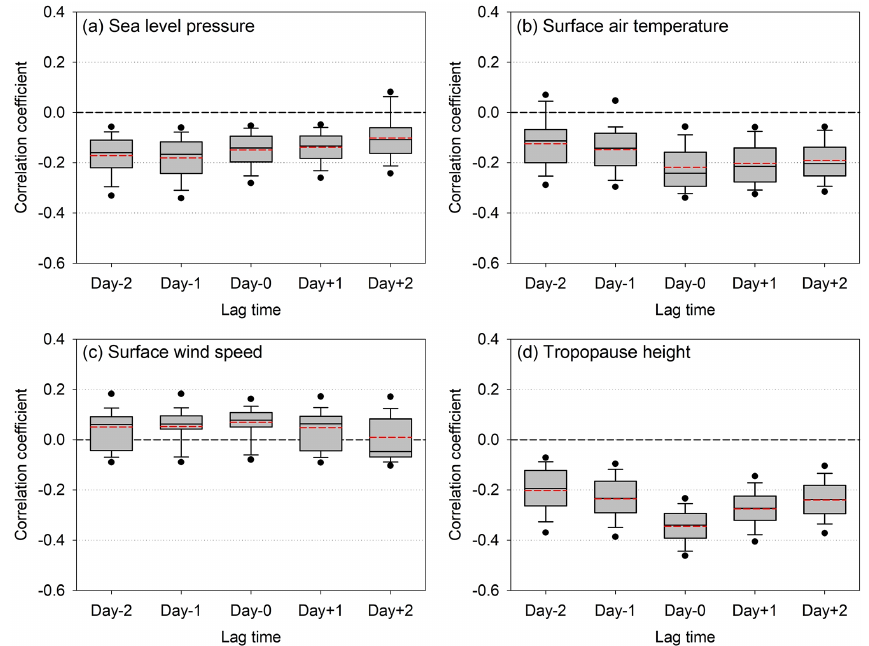
Figure 22. As Fig. 21 but for the Antarctic sea ice